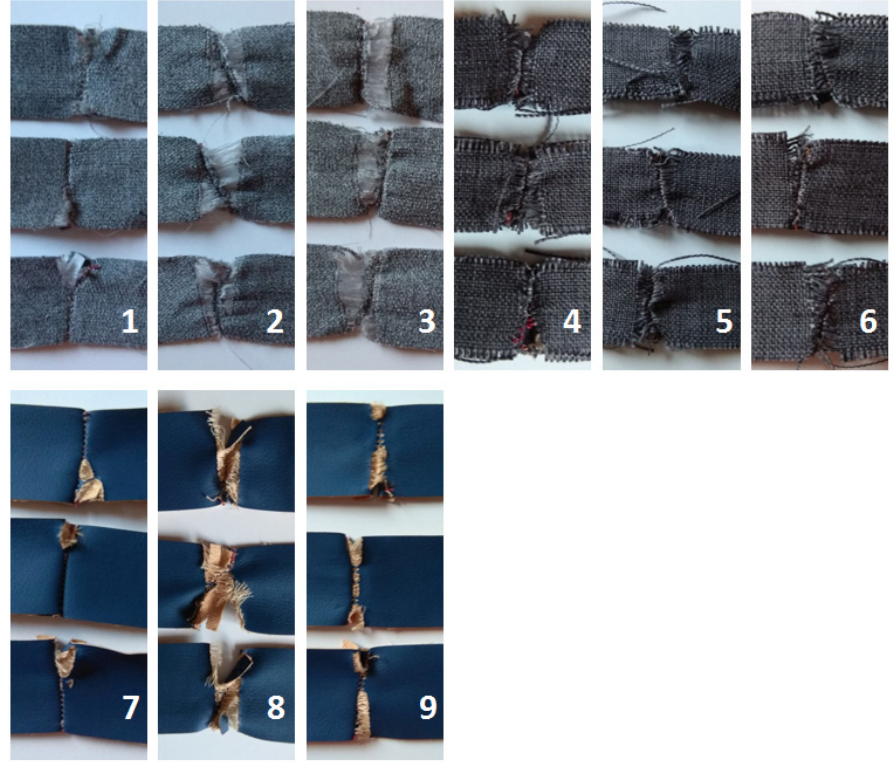
Figure 5. Summary of failure test: ( 1 ) Power 13 A-A, ( 2 ) Power 13 B-B, ( 3 ) Power 13 A-B, ( 4 ) Secret 10 A-A, ( 5 ) Secret 10 B-B, ( 6 ) Secret 10 A-B, ( 7 ) Soft 10 A-A, ( 8 ) Soft 10 B-B, ( 9 ) Soft 10 A-B.